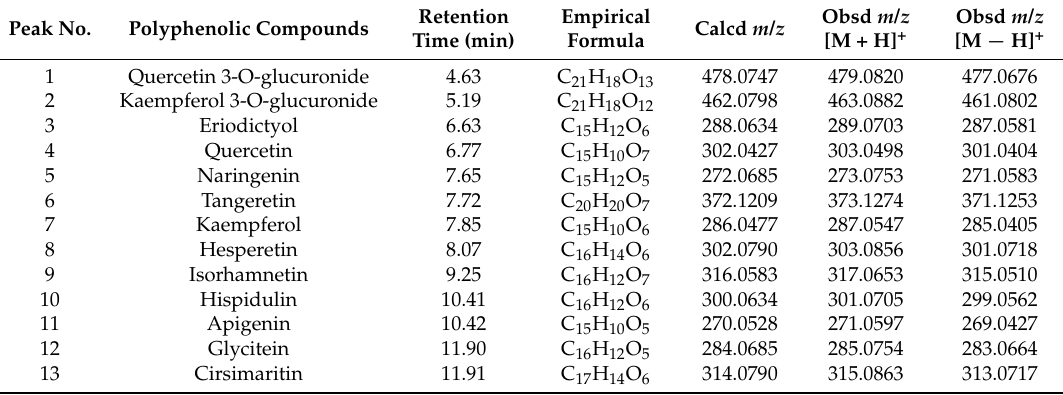
Table 2. Peak identification of T. ramosissima bark extract using UPLC-MS. Peak